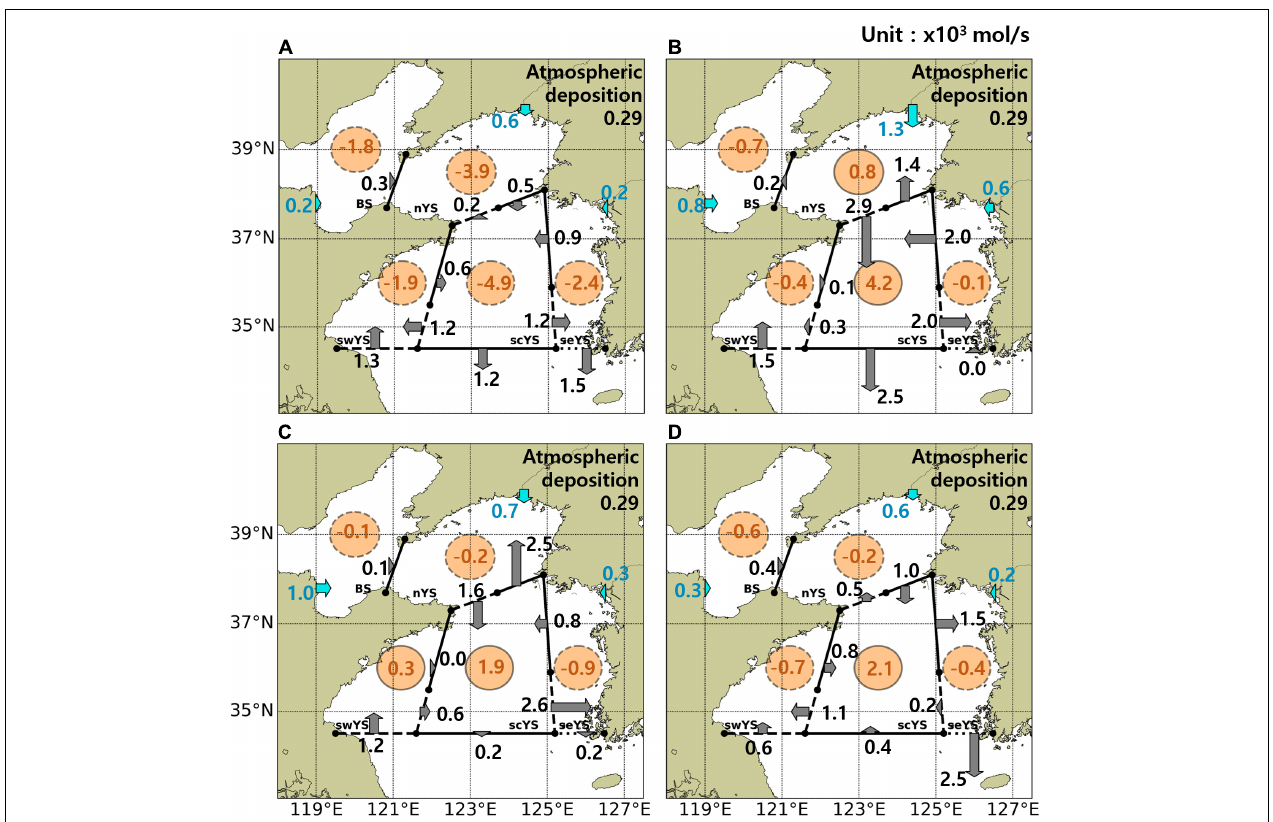
FIGURE 14 | NO 3 − ( kmol s − 1 ) budgets in subregions of the YS in spring (A) , summer (B) , fall (C) , and winter (D) averaged for the period 2006–2019. Gray arrows indicate the net advective fluxes between subregions. Cyan arrows denote the net fluxes from rivers. Orange circles denote supply (solid circle) or consumption (dashed circle) by biological processes. YS, Yellow